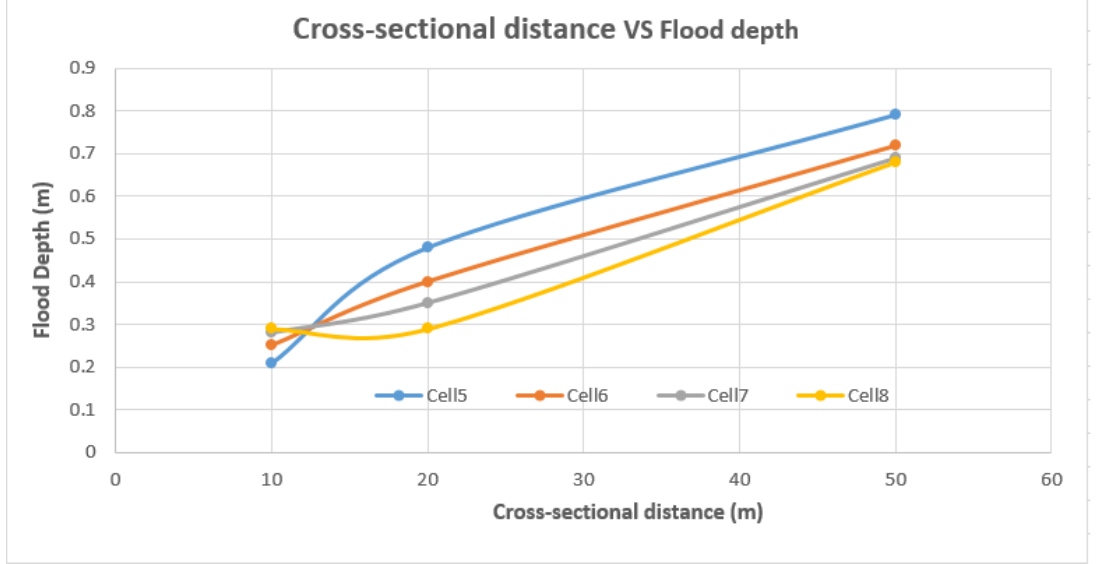
Figure 7. Change in the maximum flood depth value (Cells 5 – 8) for different cross-sectional distances in sub-reach K6.